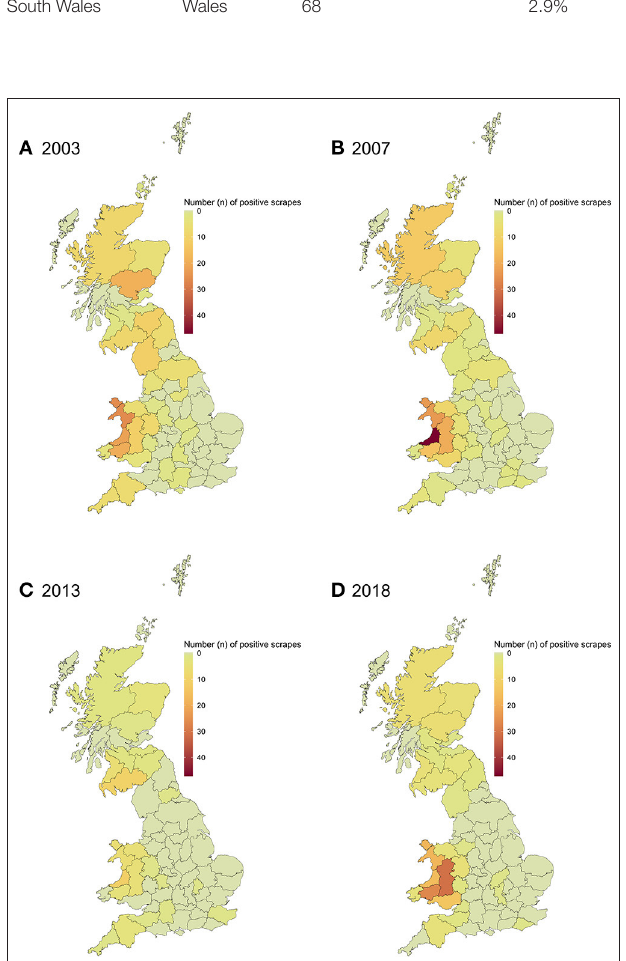
FIGURE 4 | Spatial distribution of VIDA positive scrapes in GB for four key years in the 2003–2018 study period: (A) 2003, (B) 2007, (C) 2013, and (D)